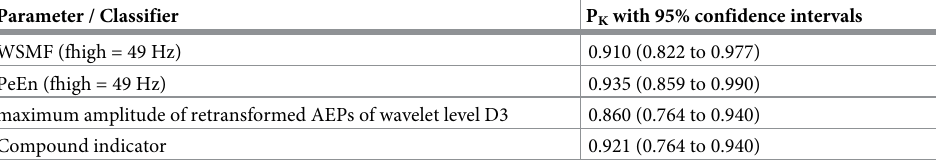
Table 3. Performance results of three single parameters as well as one compound indicator, being a SVM with an RBF kernel using 20 parameters. PK analysis was performed using a bootstrap evaluation based on the data from the ten held back patients (test set).